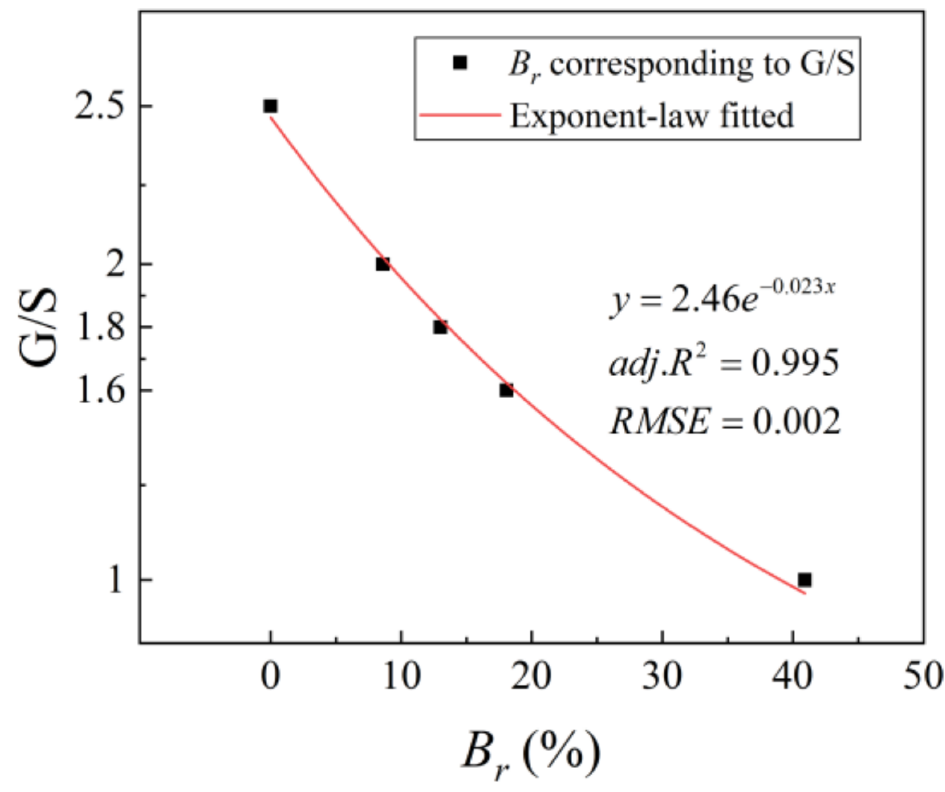
Figure 5. Fitting results of the particle breakage index values B r against the G/S parameter.